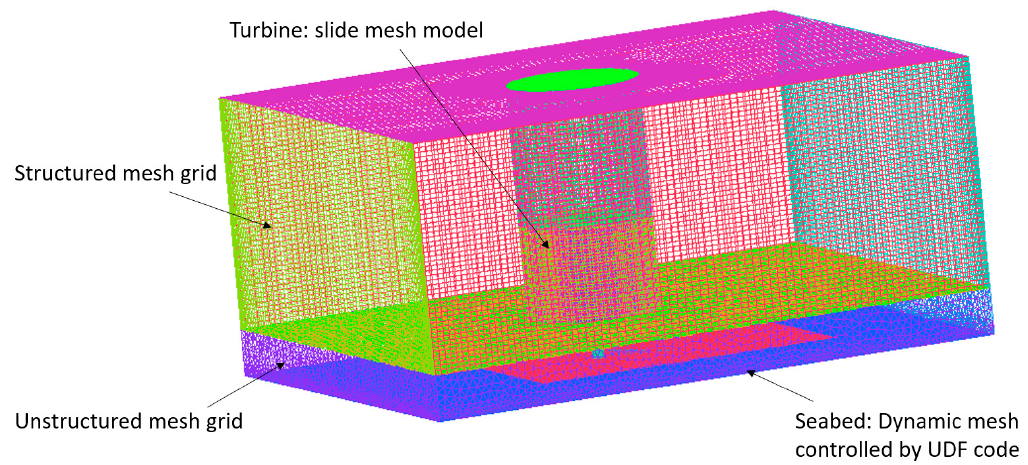
Figure 3. Computational domain of 3D turbine model.